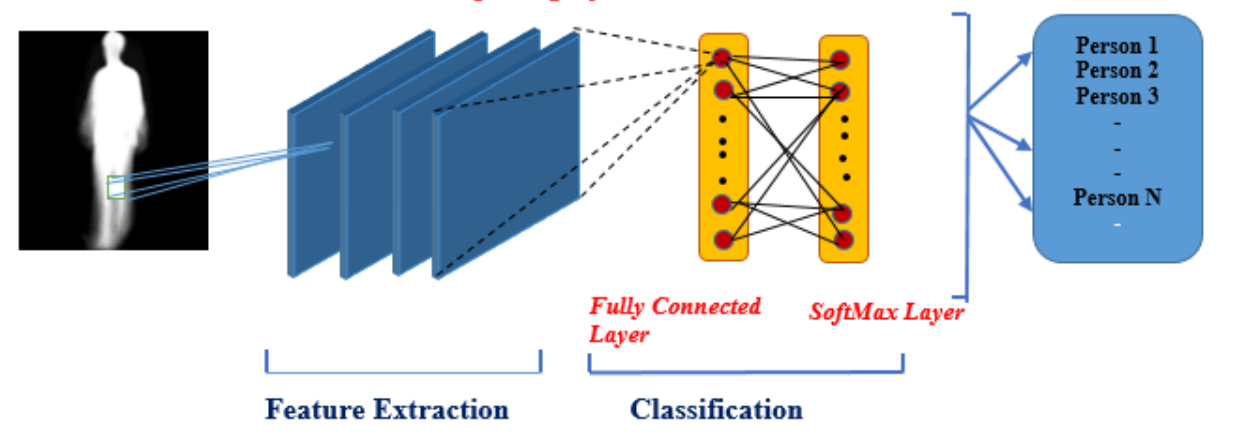
Figure 1. Gait Classification